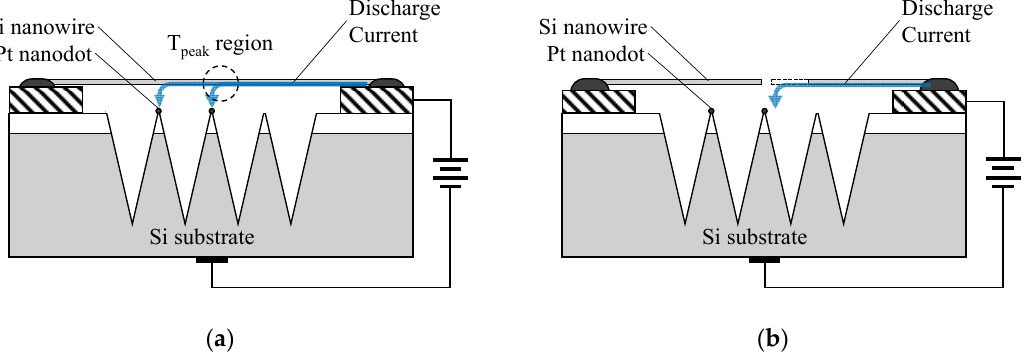
Figure 5. Schematic evolution of the nanowire failure in gas discharge: ( a ) gas breakdown current forming a concentrated high temperature region in the nanowire by Joule heating and ( b ) the local fusion of nanowire causes a fracture, where the remaining nanowire further shrinks along the subsequent discharge current flow to the nanotip.